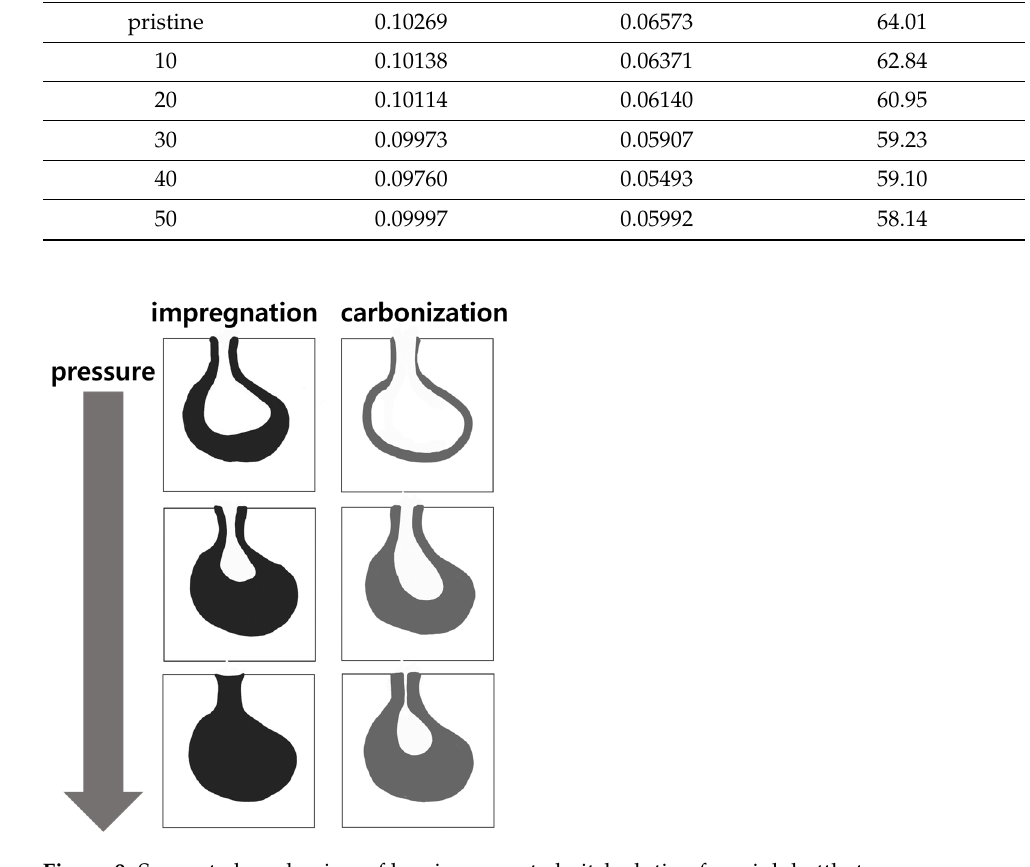
Figure 9. Suggested mechanism of less-impregnated pitch elution from ink-bottle-type pore.